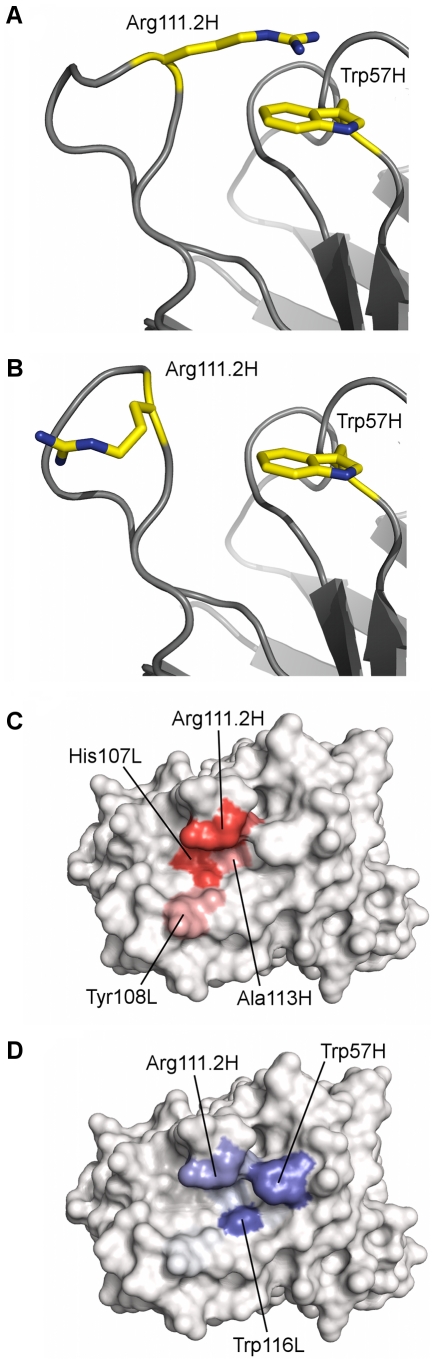
Dynamic mapping of chP3.A. The second-lowest energy conformer, highlighting the stacking between the side-chains of Arg111.2H and Trp57H. B. The tenth-lowest energy conformer, predicted to be most likely to be involved in ligand binding. C. Hydrogen bonding site map for tenth-lowest energy conformer. D. The van der Waals map for tenth-lowest energy conformer. Residues contributing to the proposed ganglioside-binding motif are highlighted on the hydrogen bonding site maps.